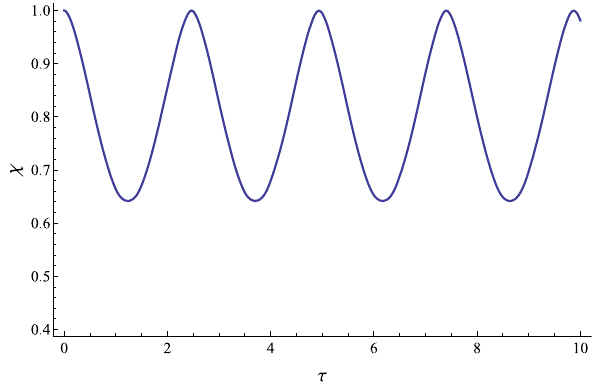
Fig. 2 The suppression factor χ(τ) . We choose p = 0 . 2, L = 1 . 234, x = 0 . 52345, T E = 1